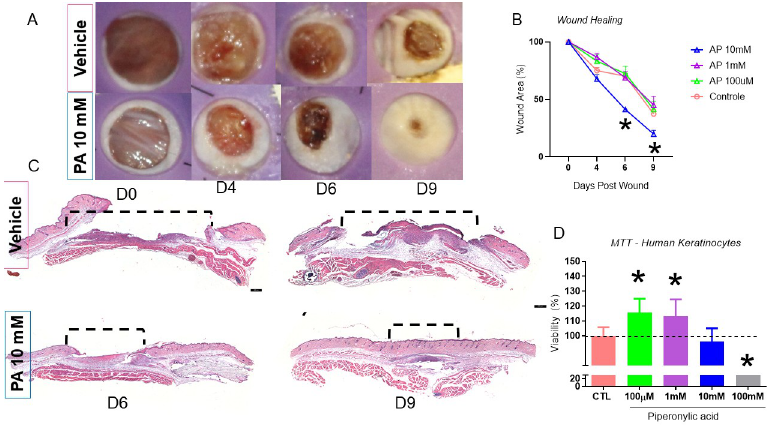
Fig 1. The macroscopic and microscopic aspects of the wounds treated for nine days with topical PA versus vehicle and HaCaT Cells treated 24 hours with PA in different concentrations for Viability Assay (MTT). Wounds were photographed (A) (representative of five distinct experiments). Wounds were treated with PA in100 μ M, 1mM, 10mM, 100mM were measured during the healing process from day 0 to day 9 (B) n = 5; � p < 0.05 and ��� p < 0.01 vs. vehicle. Microphotograph of hematoxilin/eosin staining of the wounds treated for nine days with 10mM PA vs. vehicle (C) n = 5. MTT assay, HaCaT cells incubated for 24 hours with in100 μ M, 1mM, 10mM, 100mM vs. vehicle (D) n = 3, � p < 0.05.